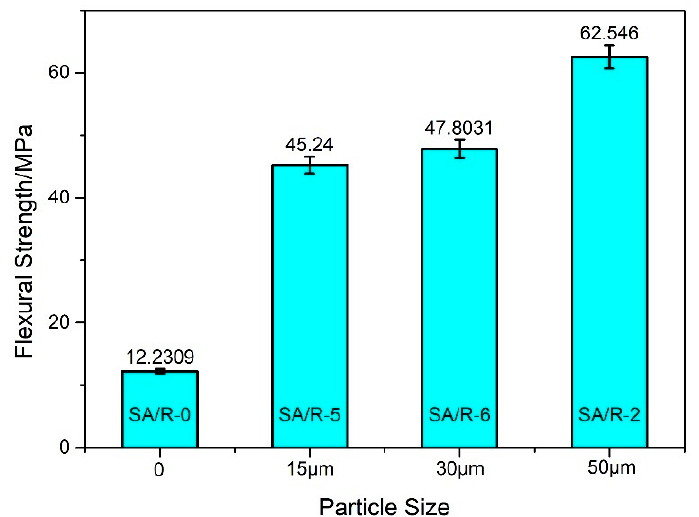
Figure 8. Effect of the particle size of silica aerogel powder on the flexural strength of the silica aerogel/resin composites.